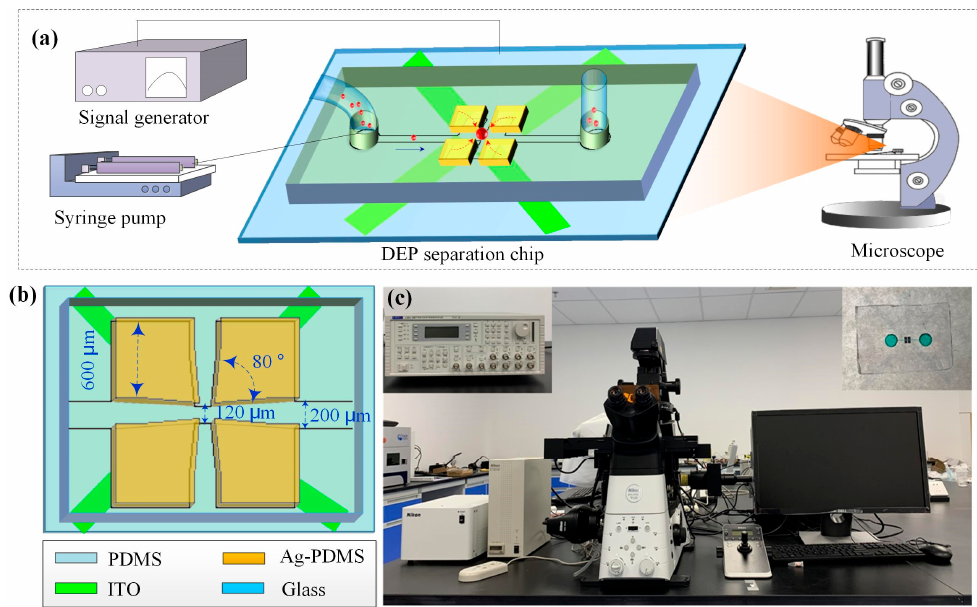
Figure 1. ( a ) Structure of the capture system, ( b ) 3D electrode, and ( c ) photograph of the